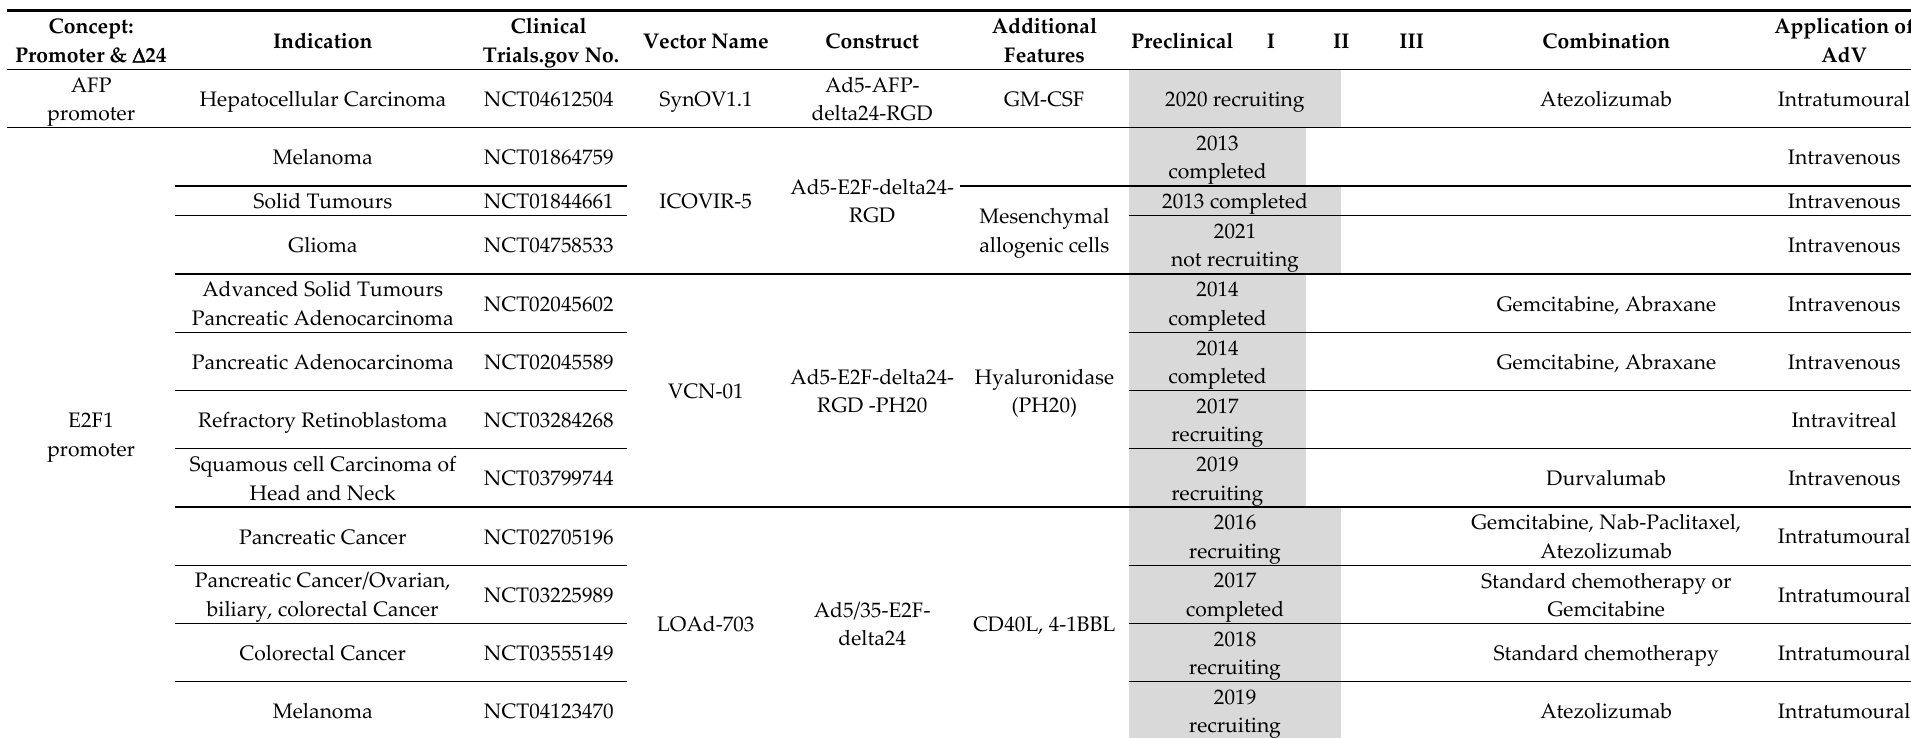
Table 2. Clinical trials using oncolytic adenoviruses in which a delta 24 variant of E1A is controlled by cellular promoters.